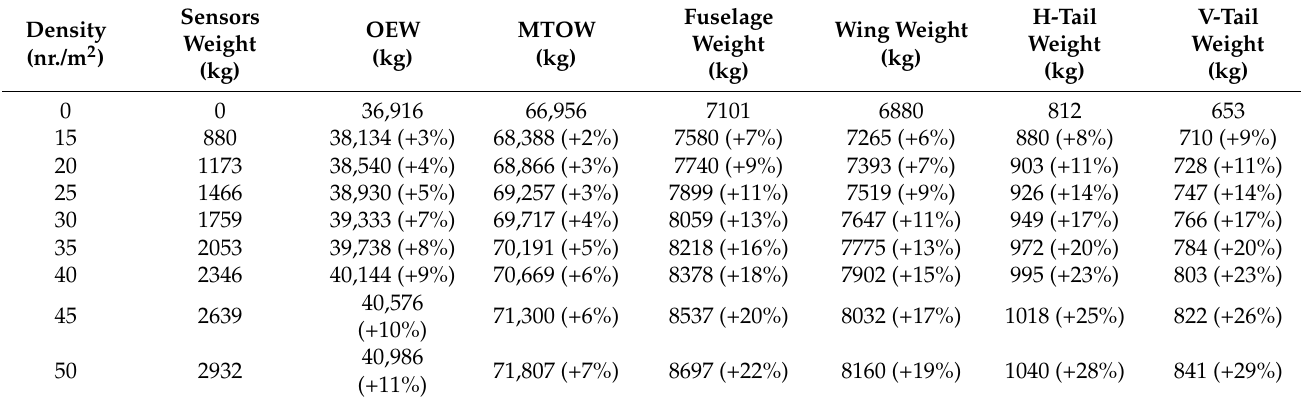
Table 16. Weight estimation for different component for each sensor